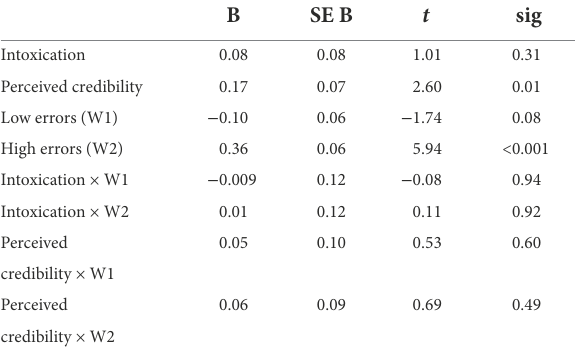
TABLE 2 Regression coefficients for predicting misinformation from perceived credibility, witness intoxication and statement errors.